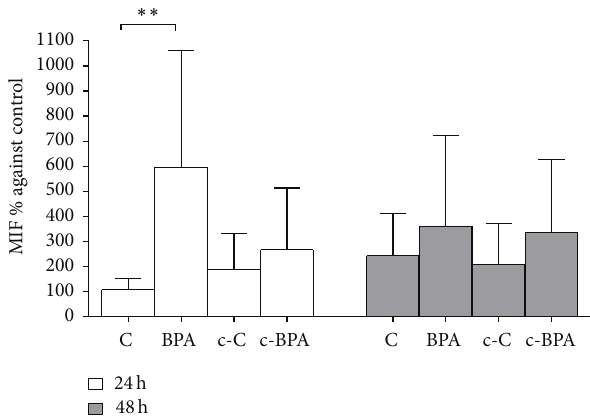
Figure 5: Concentration of MIF in the culture media of explants of chorionic villi exposed to EtOH 0.1% (C), 0.5 nM BPA (BPA), or conditioned medium from decidualized stromal cells previously exposed to vehicle (c-C) or to 1nM BPA (c-BPA). The time course lasted for 24 h (white bars) and 48h (grey bars). Values were normalized against villous explant total protein content and expressed as percentage ± SD versus C at 24h of 𝑛 = 3 separate experiments ( ∗∗ 𝑃 ≤ 0.01 BPA 24 h versus C 24 h).